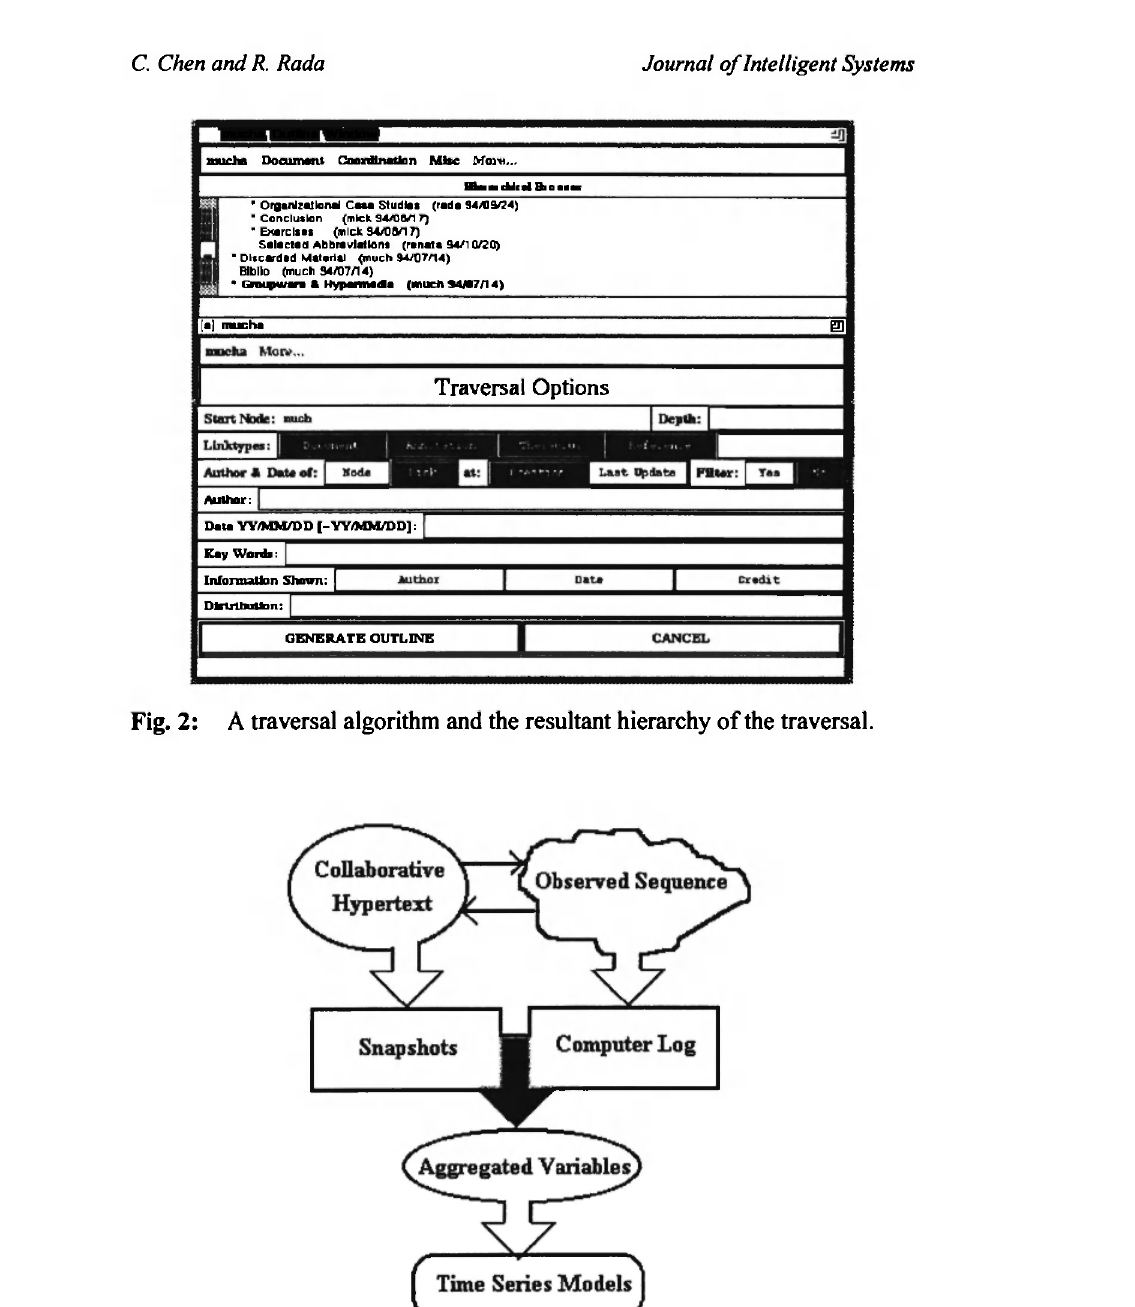
Fig. 3: Structural snapshots and interactive events are matched to derive the time series